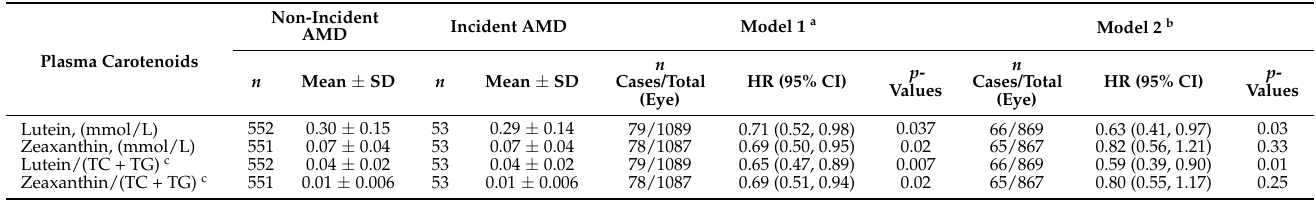
Table 2. Associations between plasma lutein, zeaxanthin, and their (TC + TG) ratios and incidence of advanced age-related macular degeneration. Alienor study, 2006–2017.